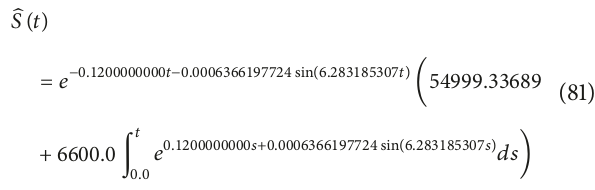
Figure 1: 𝑆 component of infection-free periodic solution. Time 𝑡 is given in years. (a) plotted only in [0, 1] . (b) Taylor expansion of